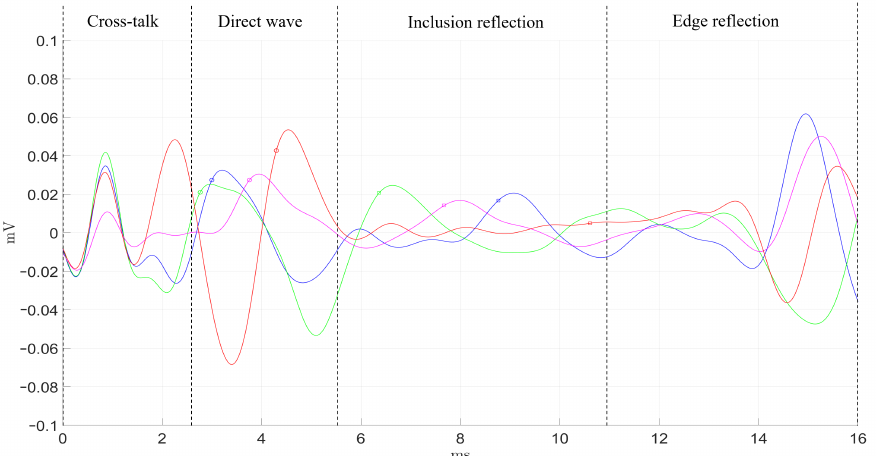
Figure 7. Readouts from the four receivers (color code in Figure 3) and expected time-of-flight of the different paths of wave propagation in Phantom B. The vertical dashed lines represent the estimated time-of-flight calculated from the shear-wave